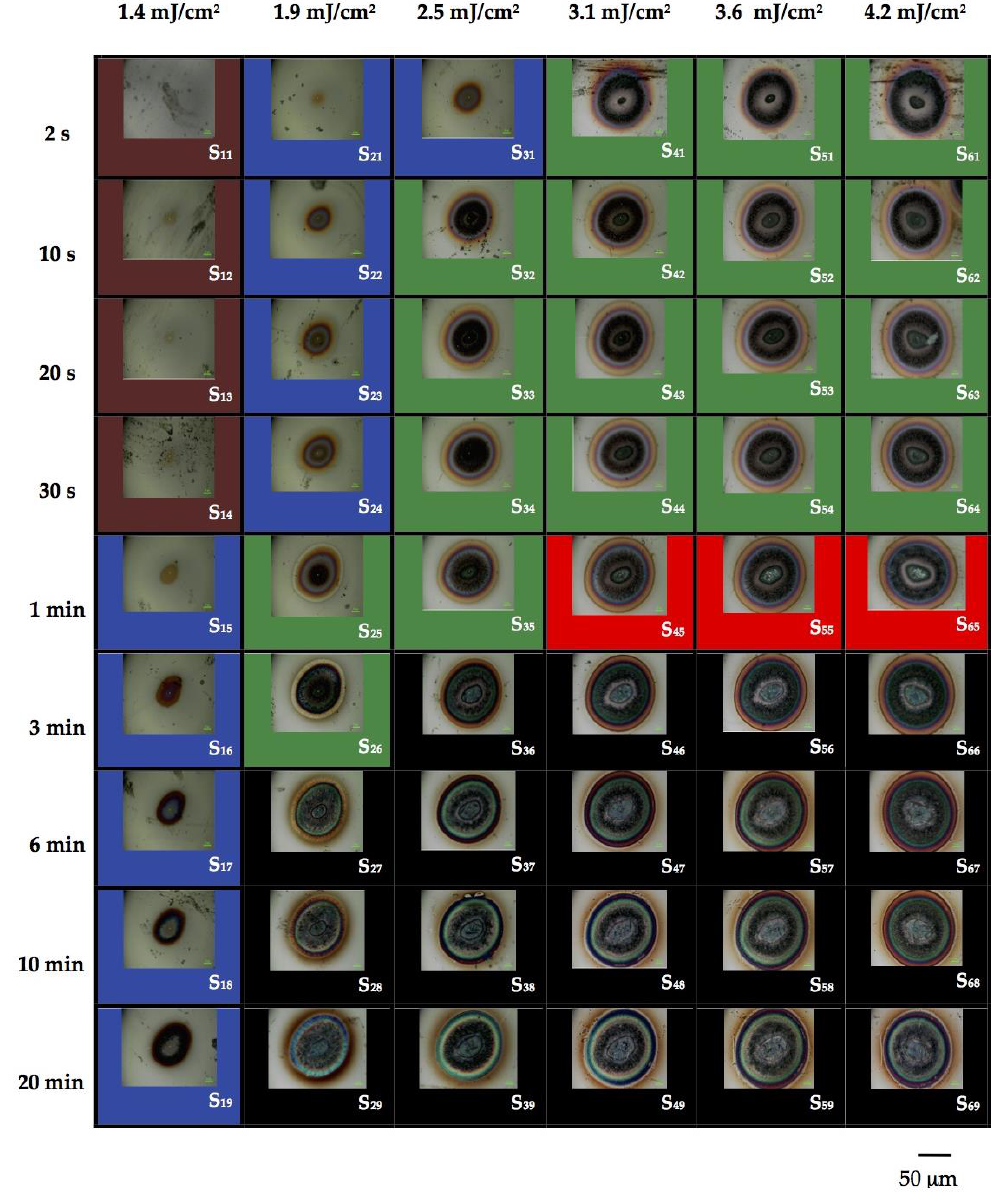
Figure 2. Optical transformation of the initial molybdenum film under increasing per-pulse laser fluence and increasing exposure time. Laser irradiation with fs laser pulses (60 fs) delivered at a 70 MHz repetition rate. The background color coding is related to the oxide phase that is obtained at the center for each irradiated spot (see Section 3.2).